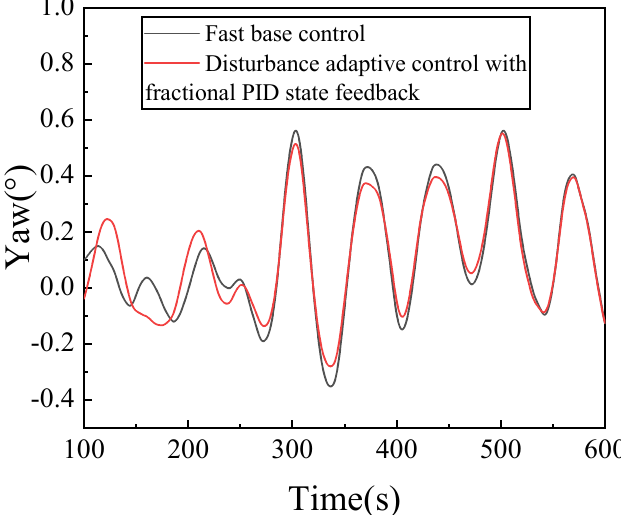
Figure 13. Comparison of roll angles under two different control algorithms.